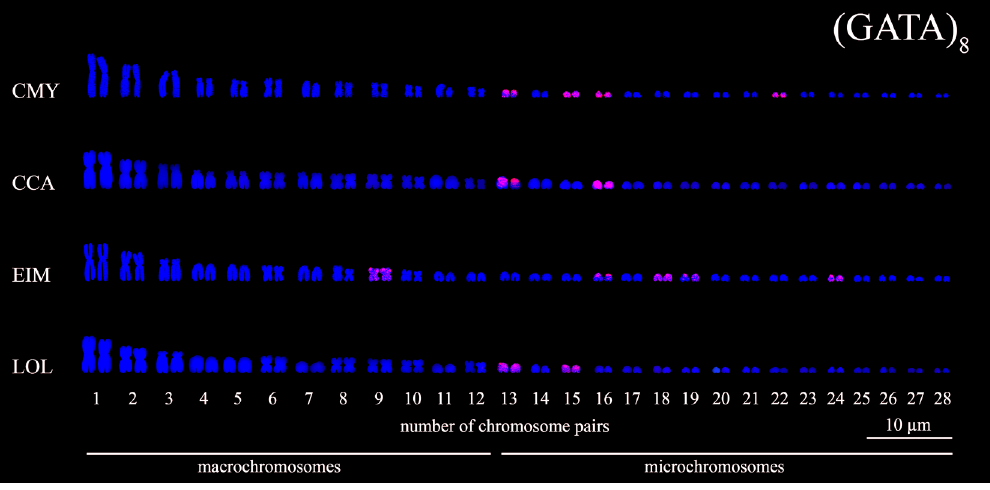
Figure 7 – Karyotypes of sea turtle species subjected to FISH using (GATA) their 3-letter acronym: C. mydas (CMY), C. caretta (CCA), E. imbricata (EIM) and L. olivacea (LOL).